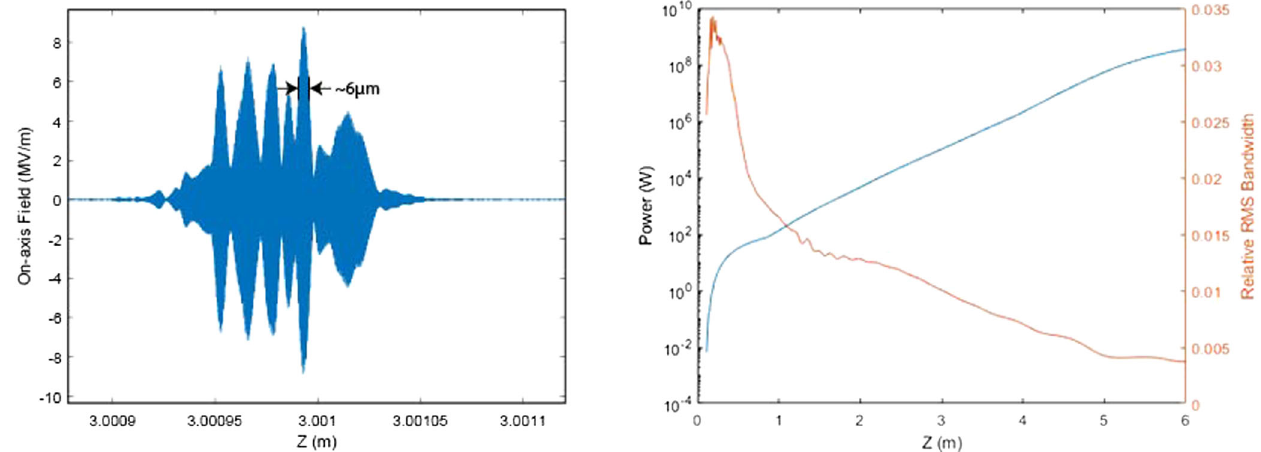
FIG. 5. Results from shot noise amplifier simulation with undulator entrance at Z ¼ 0 . 1 m. (a) On axis field profile at Z ¼ 3 m showing the characteristic spike structure. (b) Peak power and relative RMS spectral bandwidth.